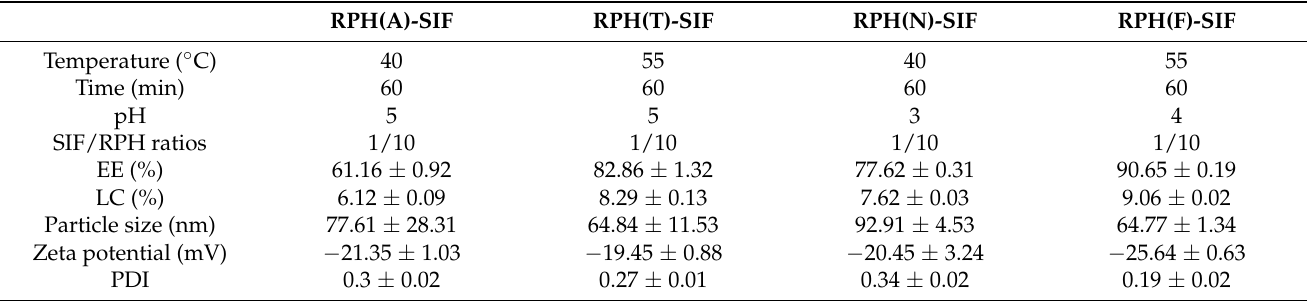
Table 1. Optimization of the preparation conditions of RPH-SIF